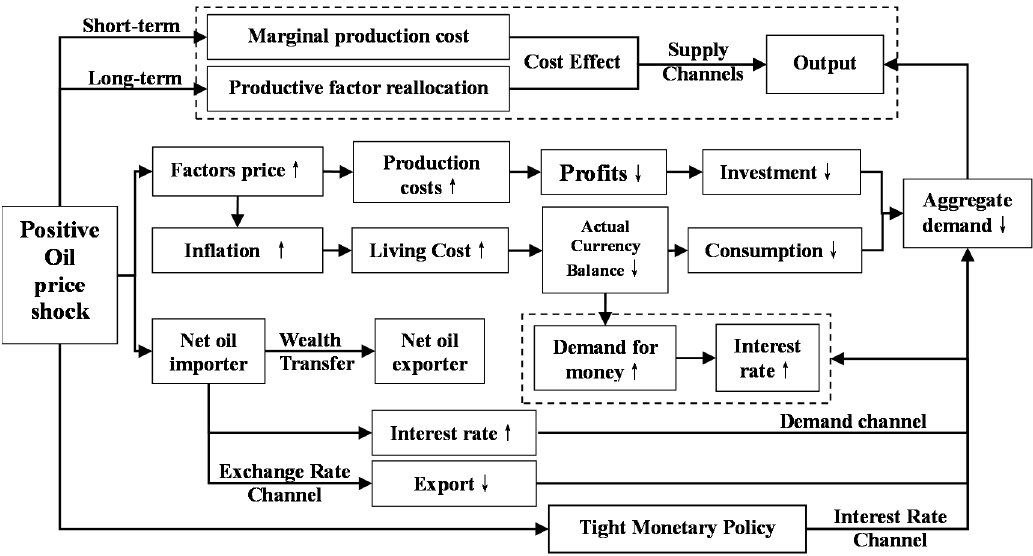
Figure 2. Transmission channel and path of action of oil price increase